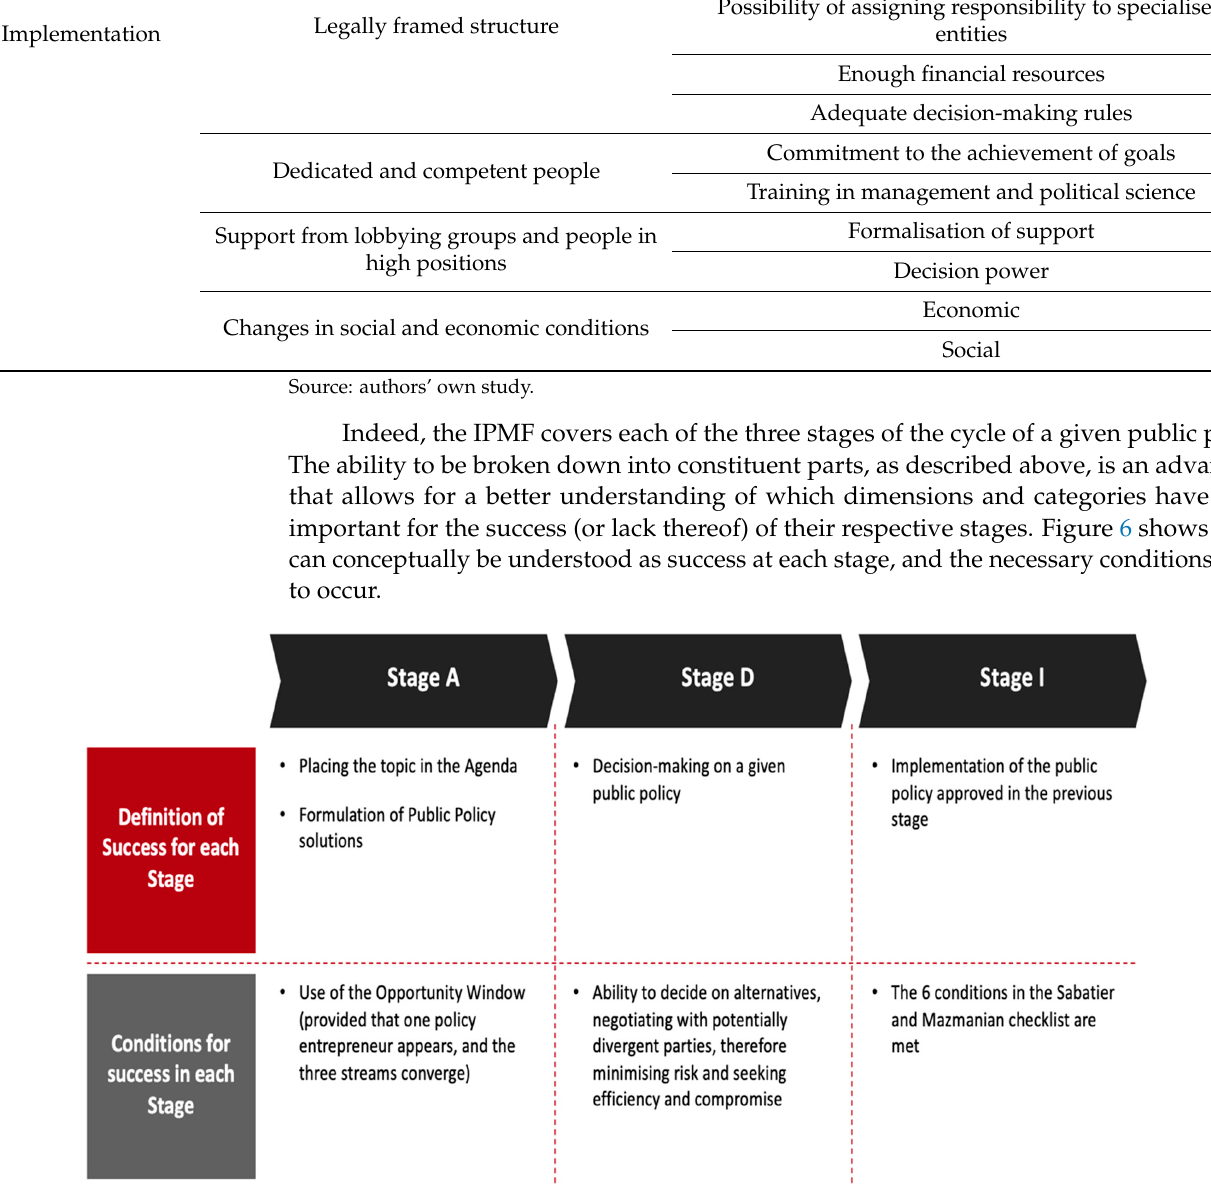
Figure 6. Definition of success and conditions for it to happen in each stage. Source: the authors.